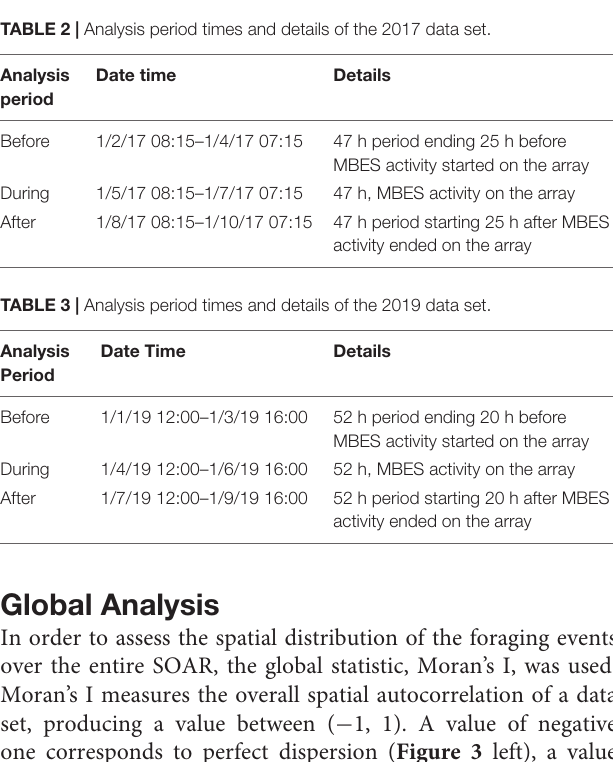
Frontiers in Marine Science |